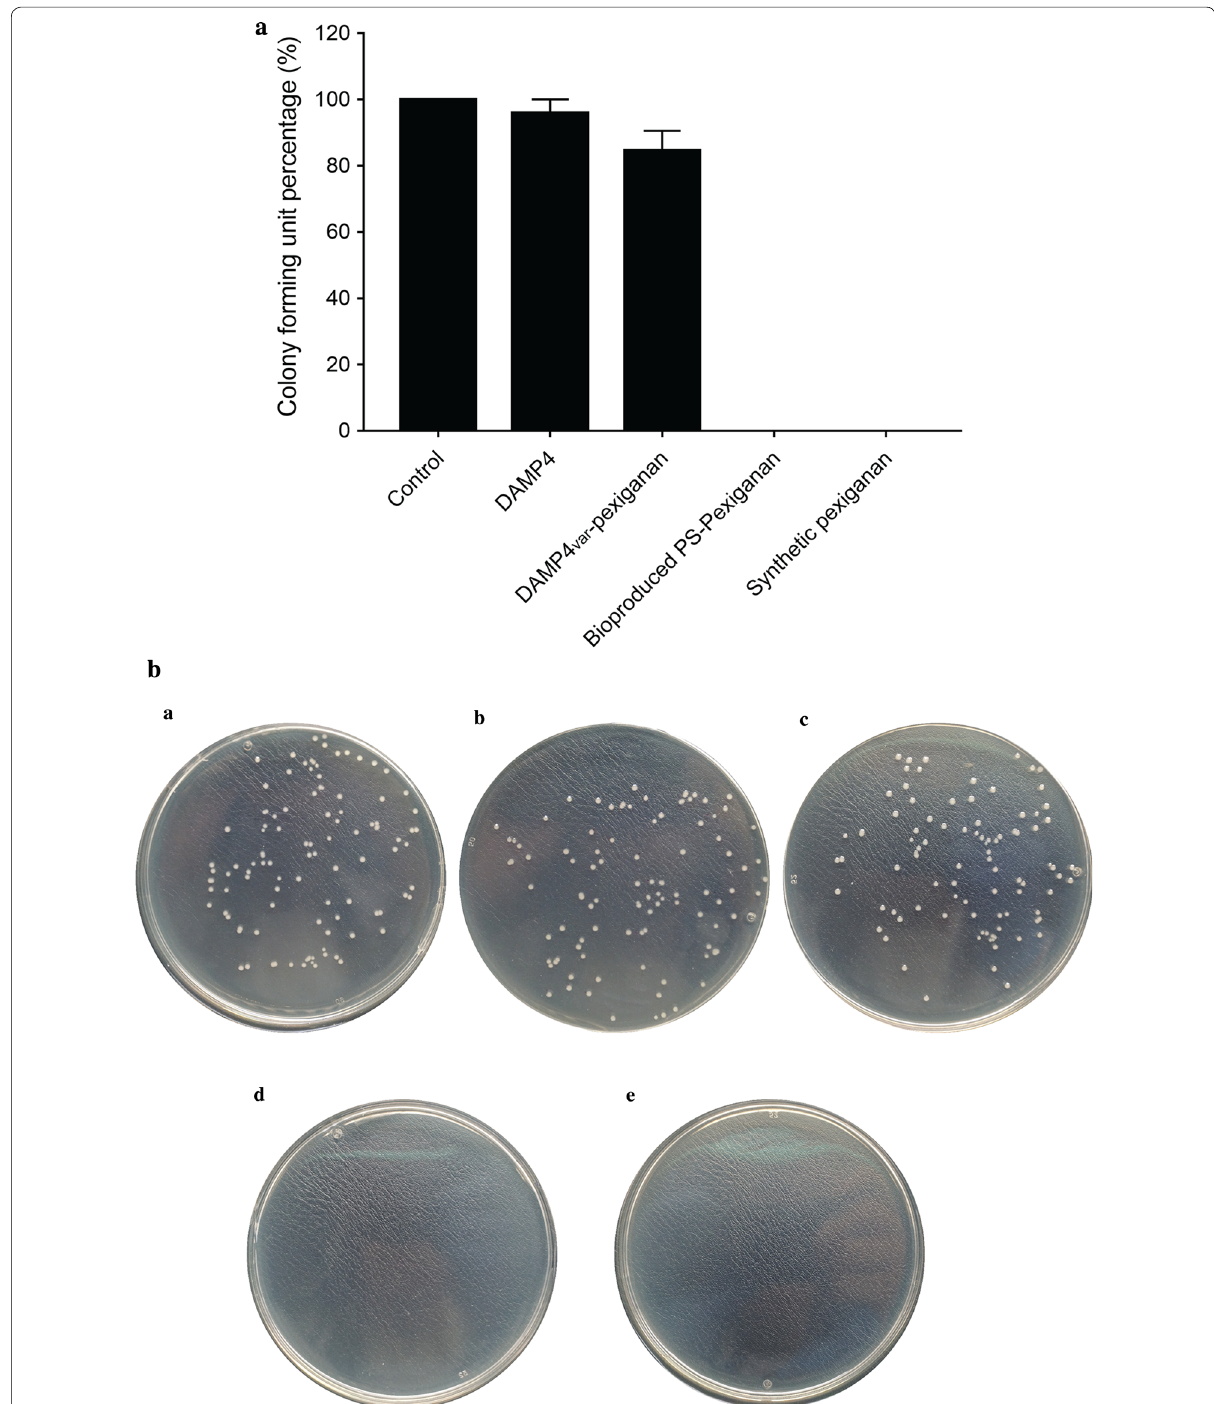
Fig. 8 Antimicrobial activity of the bio‑produced pexiganan peptide against E. coli ATCC ® 25922 ™ in comparison with controls as determined by the minimum bactericidal concentration (MBC) method. a The percentages of viable cells after MBC tests. b Photographs of E. coli growth on agar plates containing of: (a) water; (b) DAMP4 protein; (c) DAMP4 var ‑pexiganan protein; (d) synthetic pexiganan peptide; and (e) bio‑produced pexiga‑ nan peptide. The concentration of all protein/peptide samples was 16